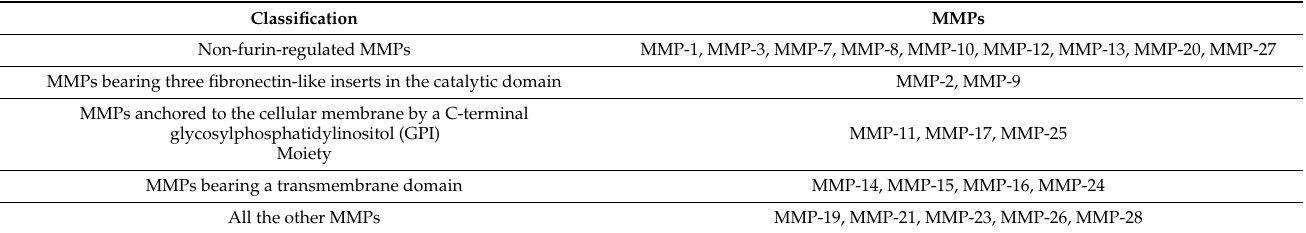
Table 1. Matrix metalloprotease (MMP) structural classification.